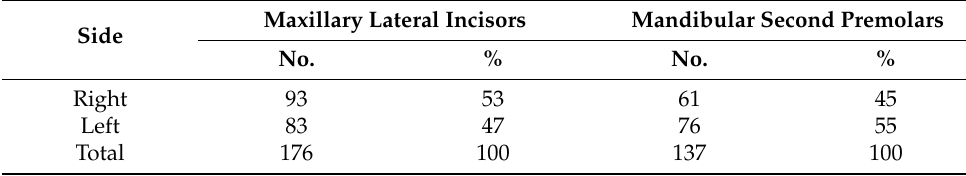
Table 2. Distribution of missing teeth by side.